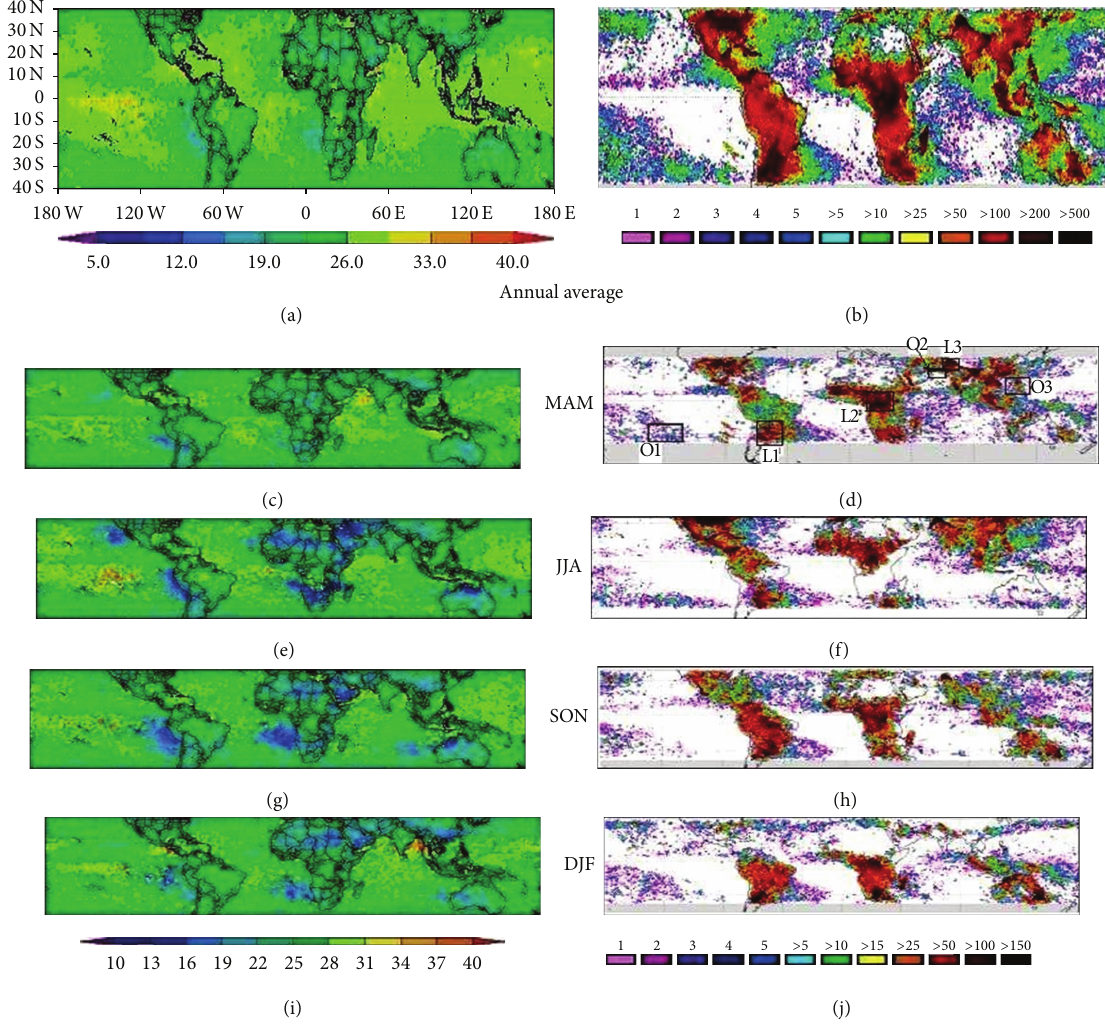
Figure 1: Spatial distribution of (a) size of cloud ice and (b) lightning for the annual average and four seasons during 2005.